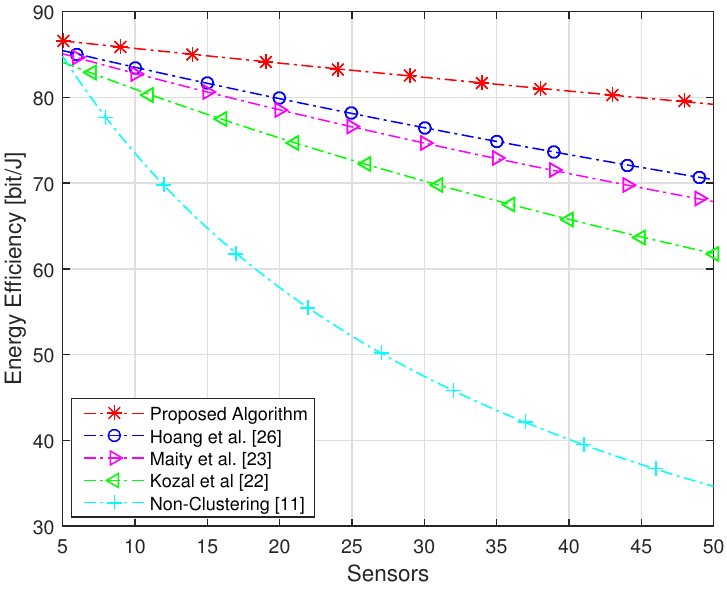
Figure 8. Energy efficiency of the whole network with an increasing number of